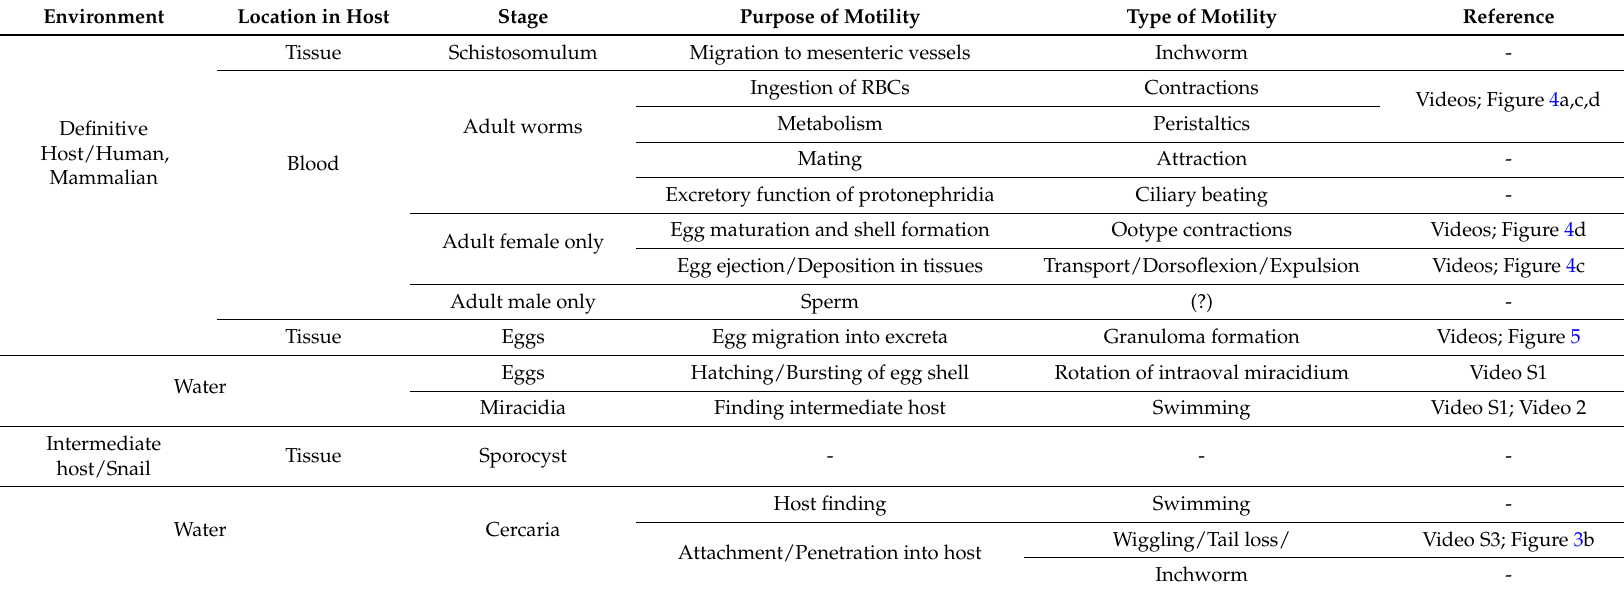
Table 1. Observed motility in the different life stages of Schistosoma mansoni (The life cycle was maintained in mice as definitive hosts and Biomphalaria glabrata intermediate hosts as described in